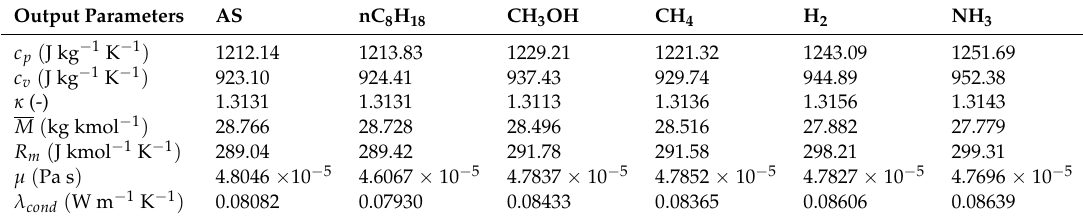
Figure 7. Inlet and outlet parameters of the schematic combustion chamber: ( a ) Fuel mass flows; ( b ) Air mass flows; ( c ) Temperatures; ( d ) Speed of sounds. Table 5. Properties of burned gas at the outlet of the schematic combustion